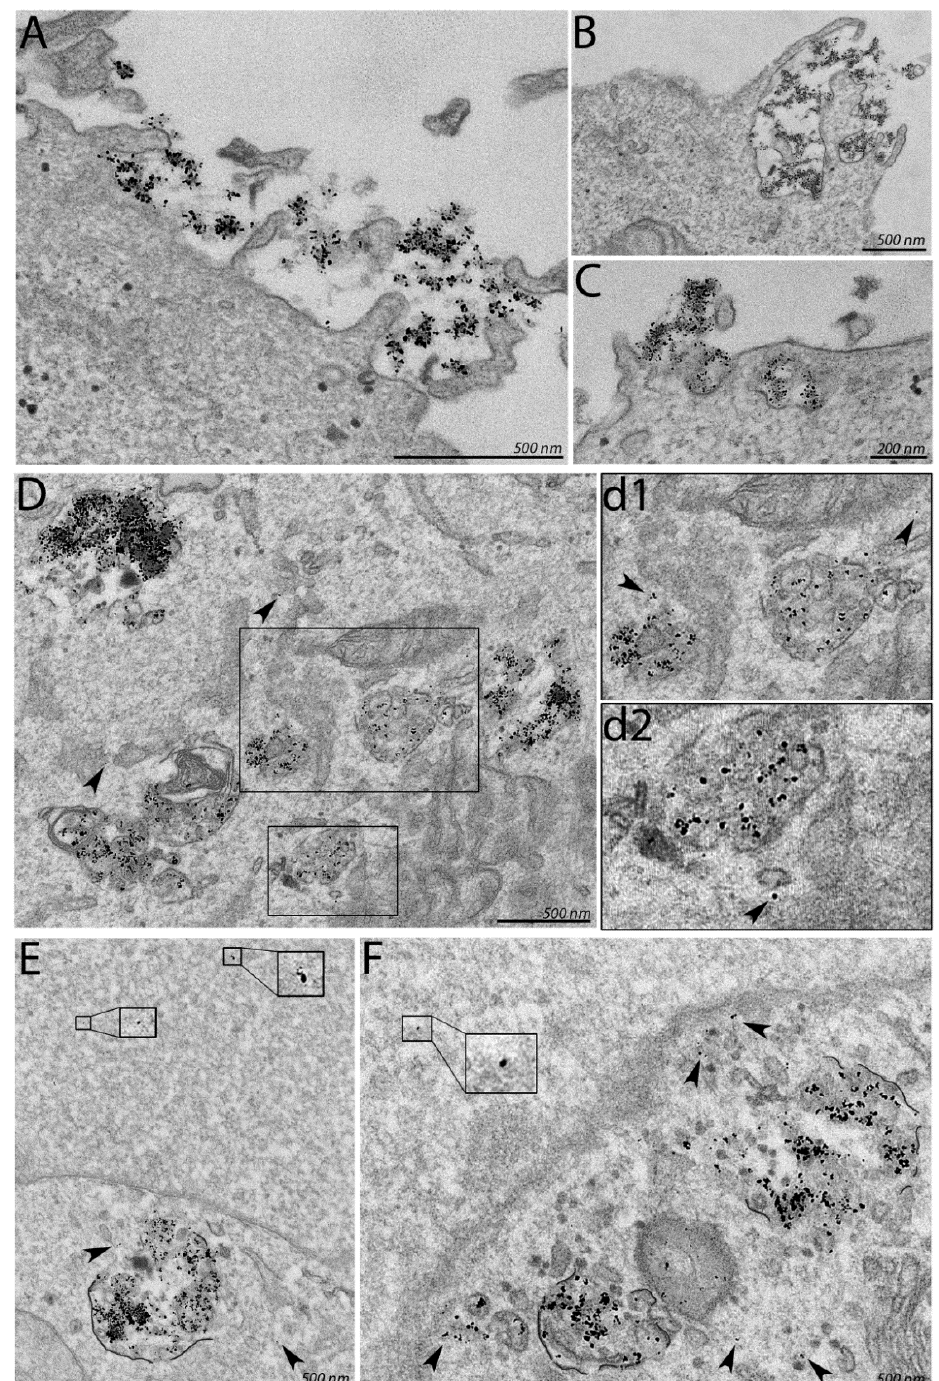
Figure 5. Internalization, endosomal escape and nuclear localization of calcium-complemented CPP-SCO nanoparticles. Cells were incubated with nanoparticles of 100 nM nanogold-labeled SCO (SCO-NG), 500 nM PF14 and 3 mM Ca 2+ for 4 h ( A – C ) or 24 h ( D – F ) and the specimens were examined at 120 kV accelerating voltage with FEI Tecnai G2 Spirit transmission electron microscope (FEI, The Netherlands). ( A ) association of nanoparticles with plasma membrane. Small black dots represent nanogold label and SCO. ( B , C ) internalization of nanoparticle by cell using endocytosis. ( D ) endosomes containing nanoparticles; ( d1 , d2 ) endosomal escape of nanoparticles. ( E , F ) SCO-NG in cell nucleus (magnified areas) and near nuclear membrane ( F ). Arrowheads indicate SCO-NG in